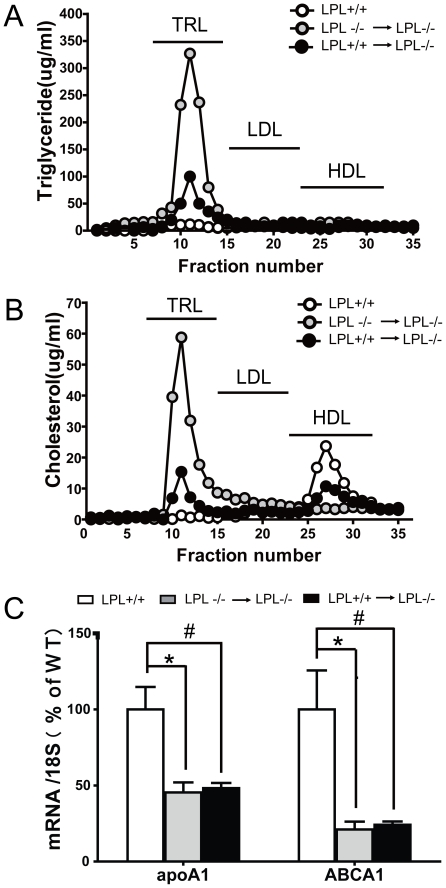
Plasma lipoprotein particle characterized by FPLC and hepatic gene expression involved in HDL synthesis.Lipoprotein profiles were determined by FPLC followed by TG (A) and cholesterol (B) analysis of each fraction. C: The expression levels of apoA1 and ABCA1 were determined by the RT-PCR methods. # p<0.05, * p<0.05, for LPL+/+→LPL-/- and LPL-/- →LPL-/- mice vs. LPL+/+ mice, respectively (n = 6 for each group).